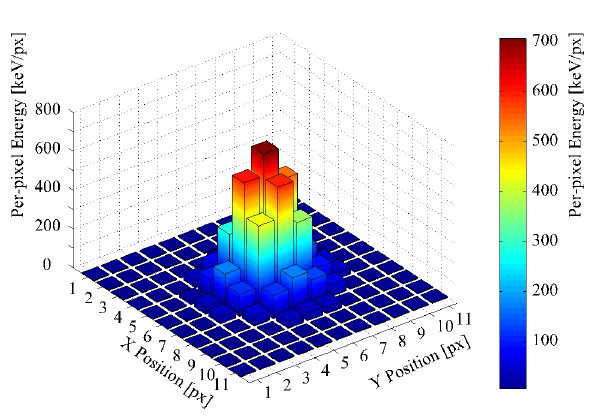
Figure 2. Registration of a proton event in Timepix operated in ToT (energy mode). The color and height of bars represents the energy of one pixel of the detec- tor.